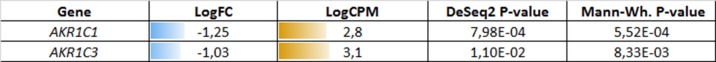
Potential markers of unfavorable prognosis in lymph node-negative LAPC involved in the enriched KEGG pathways (Russian patient cohort). LogFC—trimmed binary logarithm of average expression-level fold change (between the groups of favorable and unfavorable prognosis); LogCPM—binary logarithm of read counts per million (CPM).